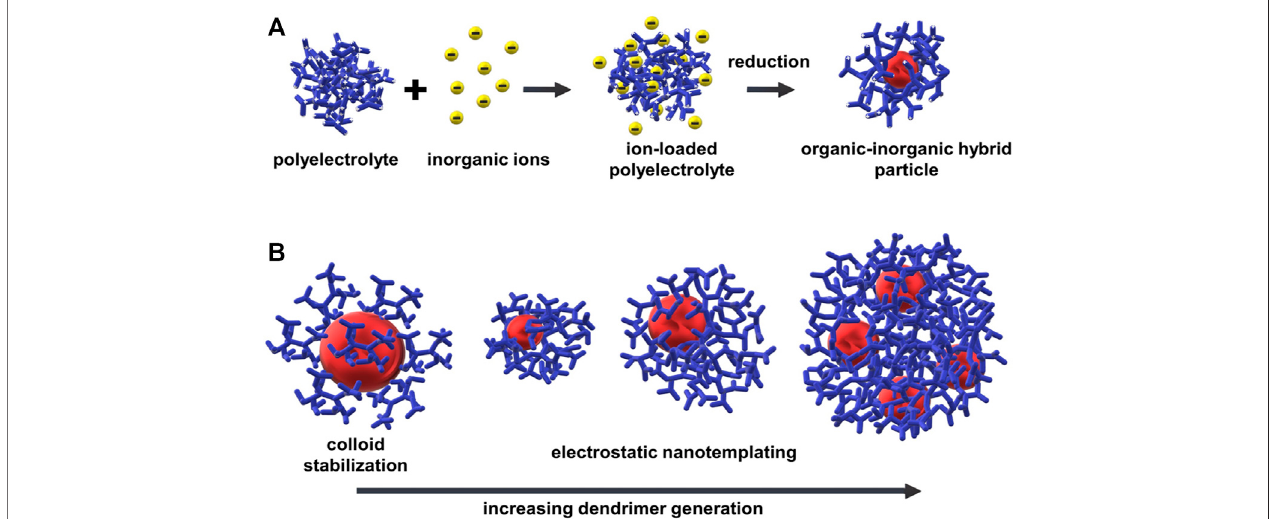
FIGURE 13 | Electrostatic nanotemplating of metal nanoparticles in a polyelectrolyte: (A) Scheme of the principle, for example, synthesis of gold nanoparticles within a high-generation polyelectrolyte dendrimer; (B) In fl uence of stabilizing mechanism and hybrid particle morphology on dendrimer generation: Colloid stabilization for G2-G4, electrostatic nanotemplating for G6-G10 (not all dendrimer branches of the dendrimers of high generations ( > G4) are shown for better visibility).